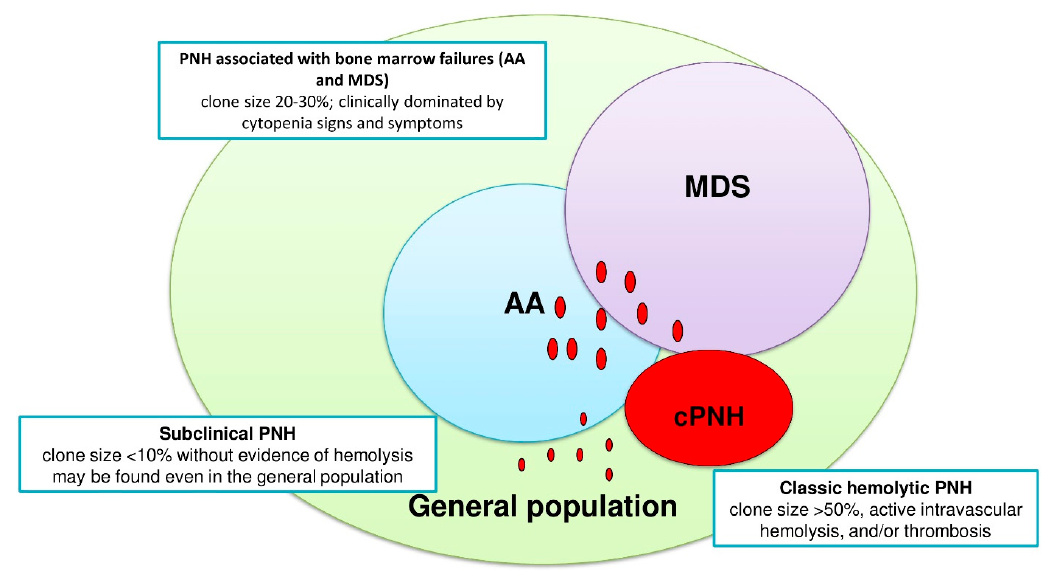
Figure 2. Paroxysmal nocturnal hemoglobinuria (PNH) subgroups according to the International PNH Interest Group (IPIG) classification: classic hemolytic PNH (cPNH), PNH associated with bone marrow failure syndromes, such as aplastic anemia (AA) or myelodysplastic syndrome (MDS), and subclinical PNH (sPNH). Red circles indicate PNH clones of various sizes: maximal (usually >50%) in classic PNH, intermediate (20% to 30%) in AA and MDS, and small or very small (<10% and <1%) in subclinical PNH.